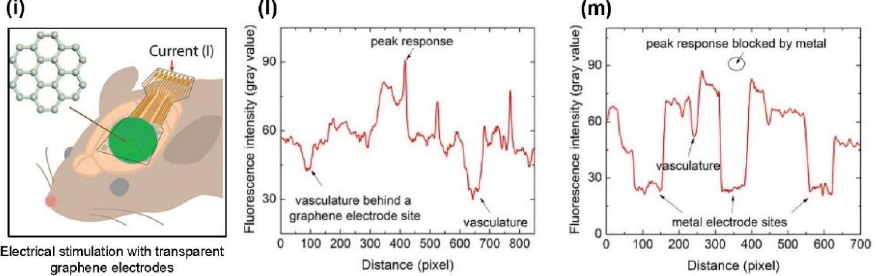
Figure 3. Graphene-based transparent devices for optical imaging and optogenetics: ( a ) photograph of a 16-electrode transparent electrocorticogram (ECoG) array. The electrode size is 300 × 300 μm 2 each; ( b ) top left: a steady-state fluorescence image of the dentate gyrus in an OBG-1 AM-stained hippocampal slice, where the blue laser and fluorescence emission penetrated through the transparent graphene electrode. Top right: region of interest (ROI) and six random cells within the electrode. Bottom: color-coded images of normalized fluorescence change (ΔF/F0) at the baseline (0 s, left) and at peak response (7.08 s, right); ( c ) time-dependent electrophysiological recording from graphene electrode demonstrates interictal-like activity; ( d ) time-dependent calcium transient (ΔF/F0) for the six cells within the ROI in b. Increases in calcium are generally consistent with interictal-like events in c. Reproduced with permission from reference Kuzum et al. [38], copyright 2014, Macmillan Publishers Limited; ( e ) schematic diagram of carbon-layered electrode array (CLEAR) device consisting of the layered structures; ( f ) schematic illustration of optogenetic testing, where the CLEAR device was implanted on the cortex of a Thyl:ChR2 mouse, with an optical fiber delivering blue laser stimuli to the neural cells; ( g ) average optical evoked responses recorded by the CLEAR device. The x-scale bar, 50 ms; y-scale bar, 100 μV. Reproduced with permission from reference Park et al. [112], copyright 2014, Macmillan Publishers Limited; ( h ) optical camera image of three types of graphene electrode arrays of different diameters (100, 150, and 200 μm); ( i ) schematic drawing of graphene μECoG electrodes implantation and electrical stimulation in GCaMP6f mice. Fluorescence images after the electrical stimulation delivered to the cortex through a single graphene electrode ( j ) and a single platinum electrode ( k ); the stimulation site is marked with a red triangle. Fluorescence intensity over ( l ) graphene electrodes (data from yellow line in j) and ( m ) platinum electrodes (data from the yellow line in k). Reproduced with permission from reference Park et al. [115], copyright 2018, American Chemical Society.